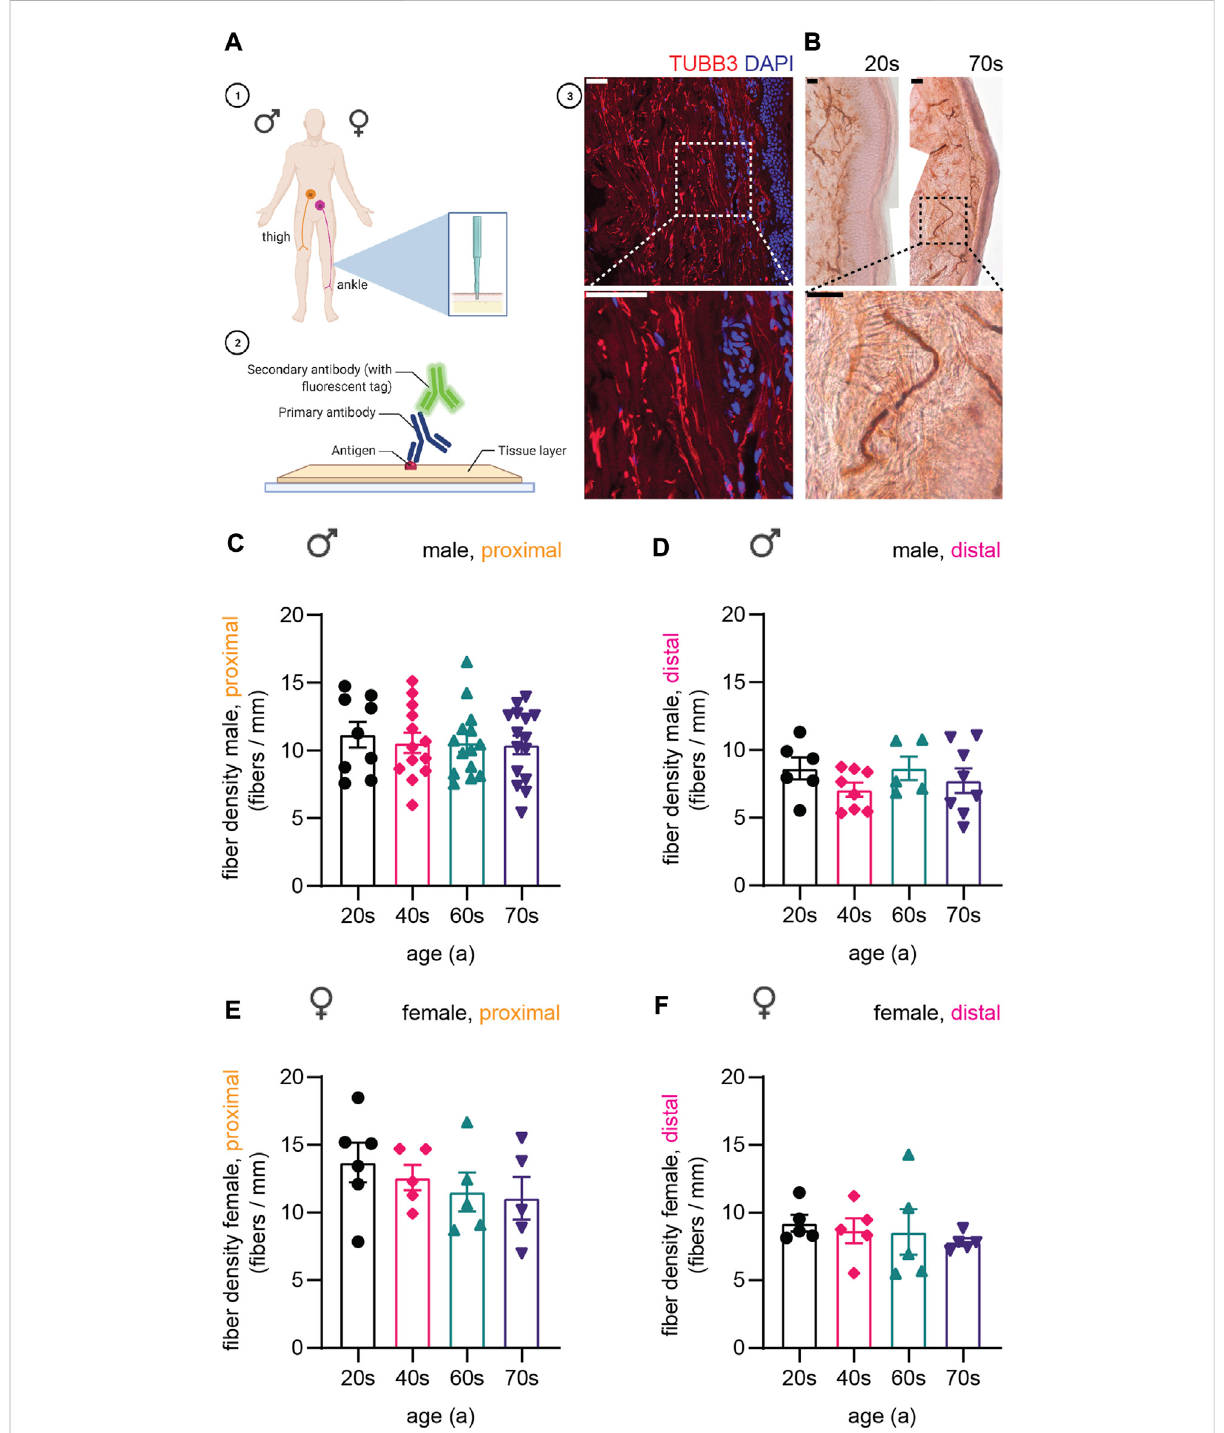
FIGURE 1 Display of experimental procedure and quanti fi cation of sensory nerve fi ber density. (A-1) Schematics of skin biopsy location: proximal (thigh) and distal (ankle) region of the leg. (A-2) Skin sections immunostained for cytoskeletal proteins. Created with BioRender.com. (A-3) Confocal image of a skin biopsy section stained for type III β -tubulin (TUBB3, red) and DAPI (nuclear stain, blue). (B) Images for immunohistochemical staining for PGP9.5 of two individuals of the youngest (20s, left) and the oldest (70s, right) age group. Higher magni fi cation of boxed area shows a single fi ber. (C – F) Quanti fi cation of IENFD for (C) male proximal, (D) male distal, (E) female proximal, and (F) female distal sample sets. One data point in (C – F) represents the IENFD value of one individual. Data represent mean ± SEM. Scale bars in (A-3) and (B) are 50